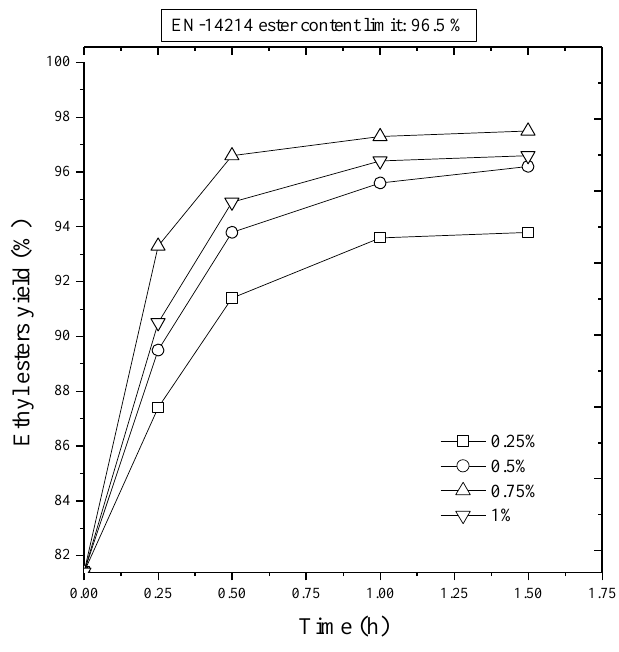
Figure 4. Second stage transesterification. Effect of the mass ratio of NaOH to sunflower oil on ethyl ester yield. Ethanol/oil molar ratio, 6:1; reaction temperature, 80